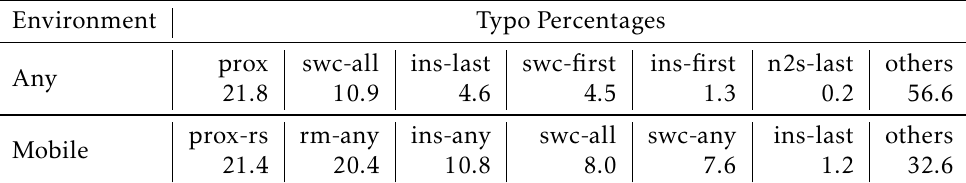
Table 2. Top typos that occurin the mobiledataset and general